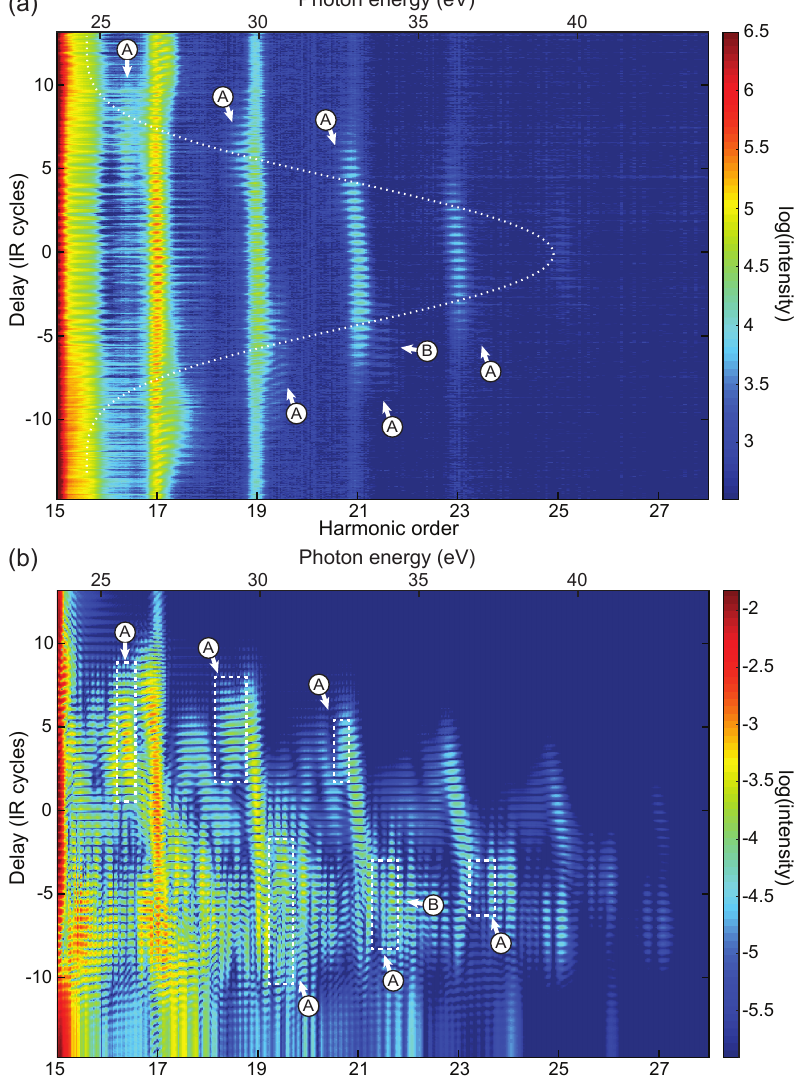
Figure 3. XUV-initiated HHG spectra as a function of the XUV–IR delay. ( a ) Experimental data. The arrows indicate characteristic features in the spectrum: A, strongly frequency-shifted spectral components, with positive (negative) shifts for negative (positive) XUV–IR delays; B, sub-cycle temporal delay of the oscillations of the shifted spectral components with respect to odd harmonic signals. The white dotted curve sketches the cutoff as it follows the envelope of the 25 fs IR pulse. The pedestal artifacts from Figure 2 are also visible in this plot. ( b ) TDSE calculation results. The characteristic features are also found in the single atom response calculation. Some TDSE features are not found in the experiment, for example most of the signal is between the odd harmonics at negative delays. As a guide to the eye we display white-dashed boxes around the A-type features found in the